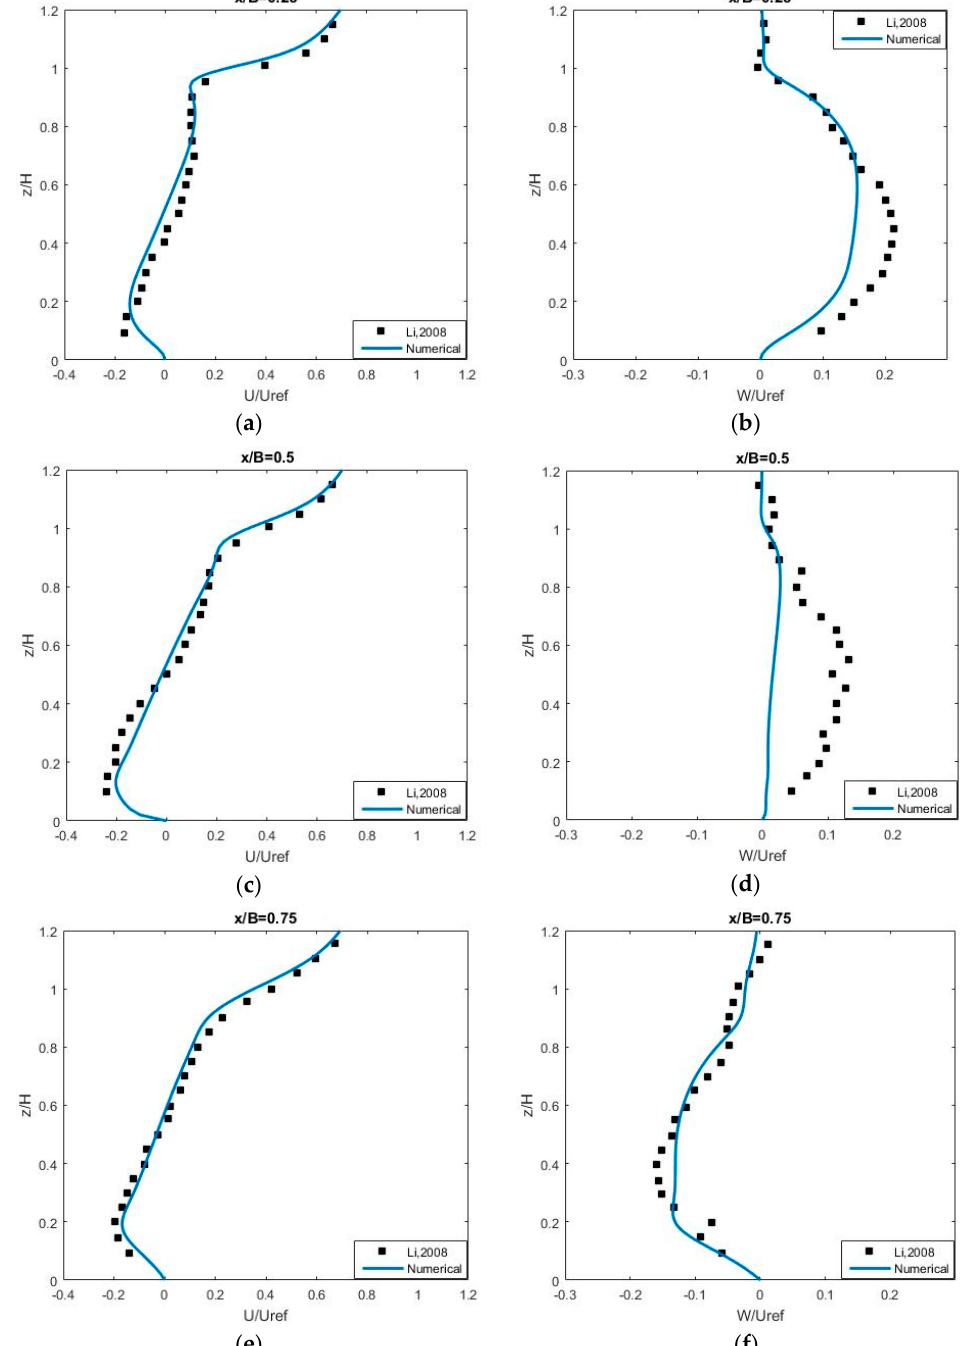
Figure 9. The vertical profile of normalized stream-wise U / U ref ( a , c , e ) and vertical W / U ref ( b , d , f ) velocities with AR =